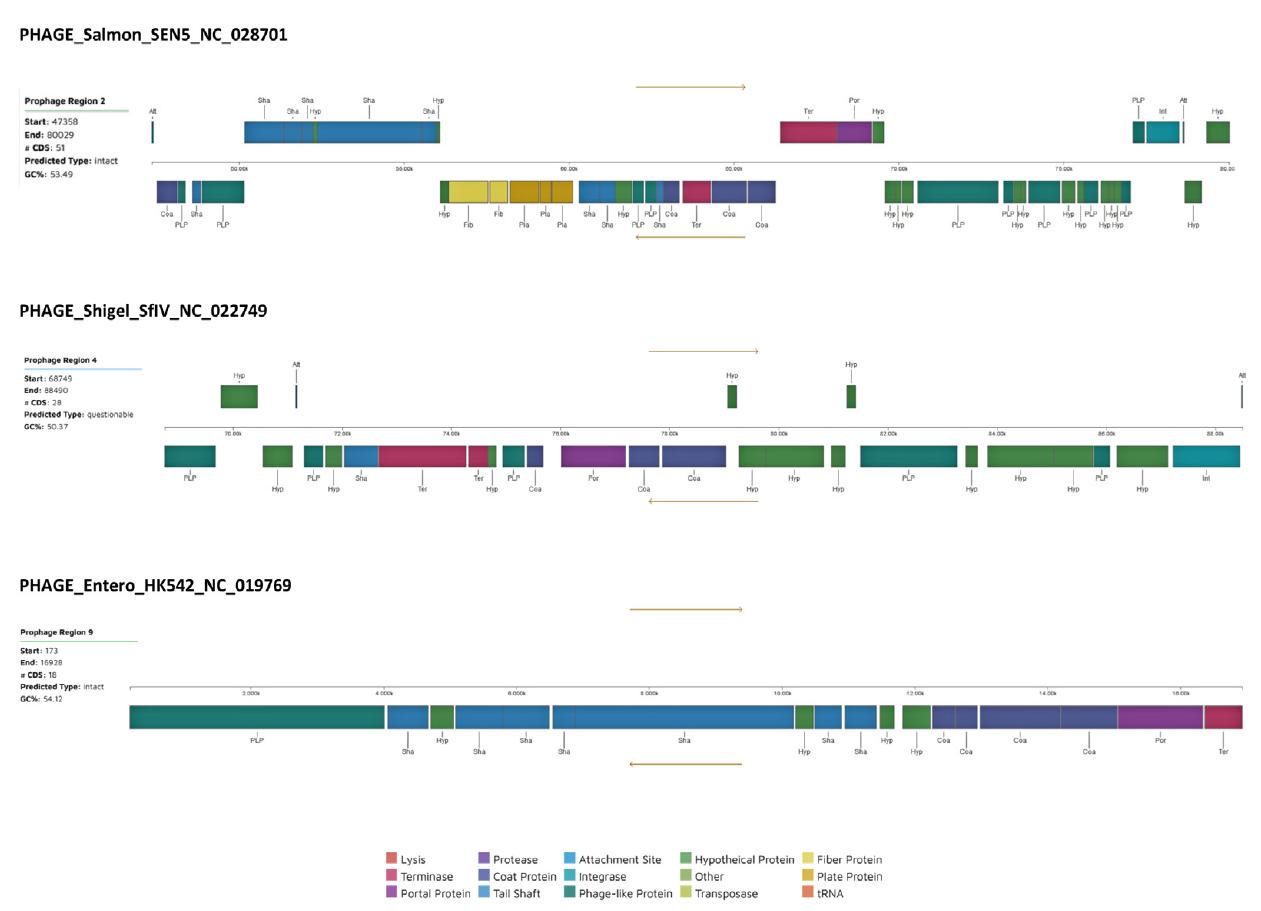
Figure 2. Schematic representation of phage-related proteins identified in the intact and questionable prophages by PHASTER prophage database (https://phaster.ca, accessed on 4 January 2022) [49]. The arrow indicates the sequence orientation (5 ′ to 3 ′ above the black line and 3 ′ to 5 ′ under it). The abbreviations are: Att (phage attachment site), Coa (Phage coat protein), Fib (Phage Tail Fibre), Int (Phage integrase), Hyp (Hypothetical protein), Pla (Phage plate protein), PLP (Phage- like protein), Por (Portal protein), Sha (Phage tail shaft protein) and Ter (Terminase). The mcr-9 gene was found in a 30,314 bp length contig, manually assembled after visual inspection and alignment of contigs (Aq77p_57, Aq77p_155, Aq77p_191, Aq77p_196, Aq77p_213) against themselves using CLC Genomics Finishing Module v.20.0.1 (QIAGEN, Aarhus); the GC content was 47.6%. The analysis of mcr-9 -harbouring contig using the Mi- crobial Nucleotide MegaBLAST analysis against the complete plasmids database revealed nine mcr-9 -carrying IncHI2 plasmid sequences (>99.9% identity, >97% query coverage and e-value 0.0) from multiple species, collected in different antibiotic resistance reservoirs worldwide, including human clinical/colonization samples (Table 2). Of notice, three plasmids of sequence type 1 (ST1), accordingly with the IncHI2 pDLST scheme, were col- lected from environmental samples during an extended bla IMP-4 -associated carbapenemase outbreak in an Australian hospital